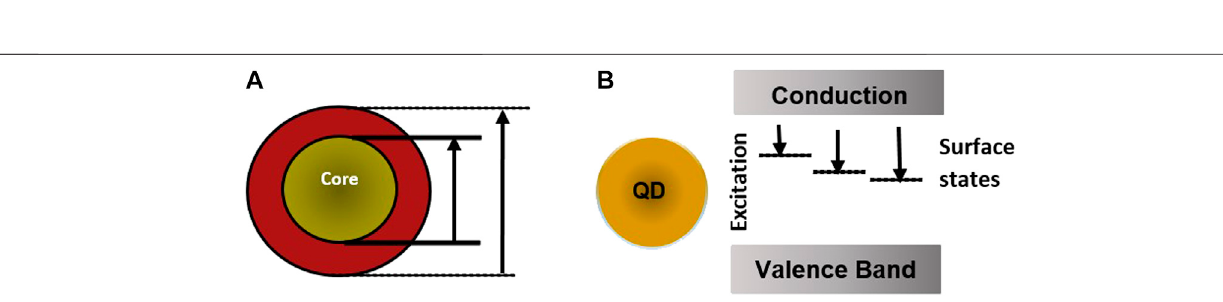
FIGURE5| Diagramillustrationofthesolidbandstructures: (A) WithintheQDsbandgap,thesurfacetrapstheirelectronictransitions. (B) Core-shellQDelectronic structure made of two semiconductors forming heterojunctions [48].